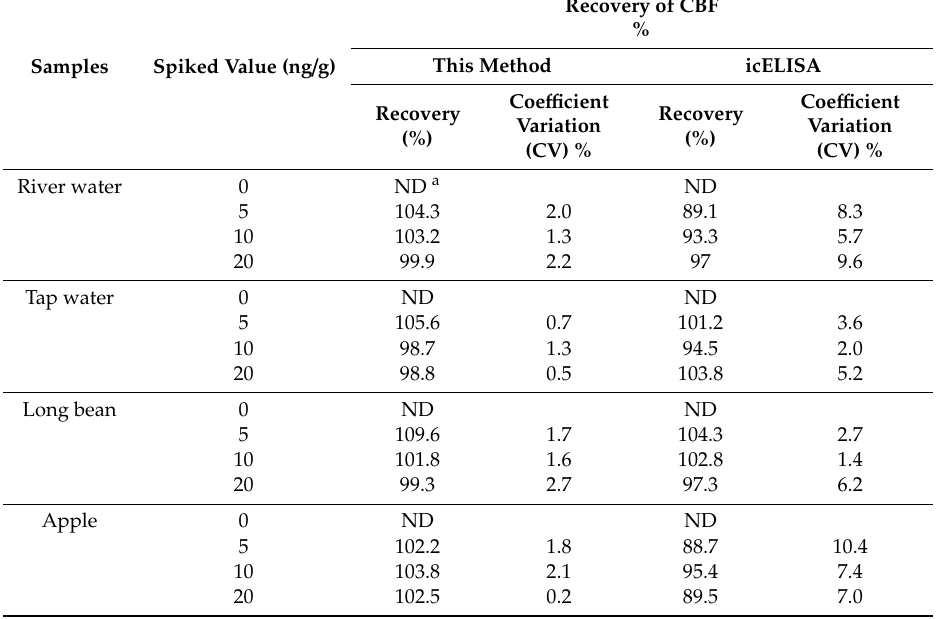
Table 2. Recoveries of samples spiked with CBF and 3-OH-CBF, respectively, by using the immunosensor and icELISA. Each data represents the average intensity with standard deviation (SD) in triplicate.